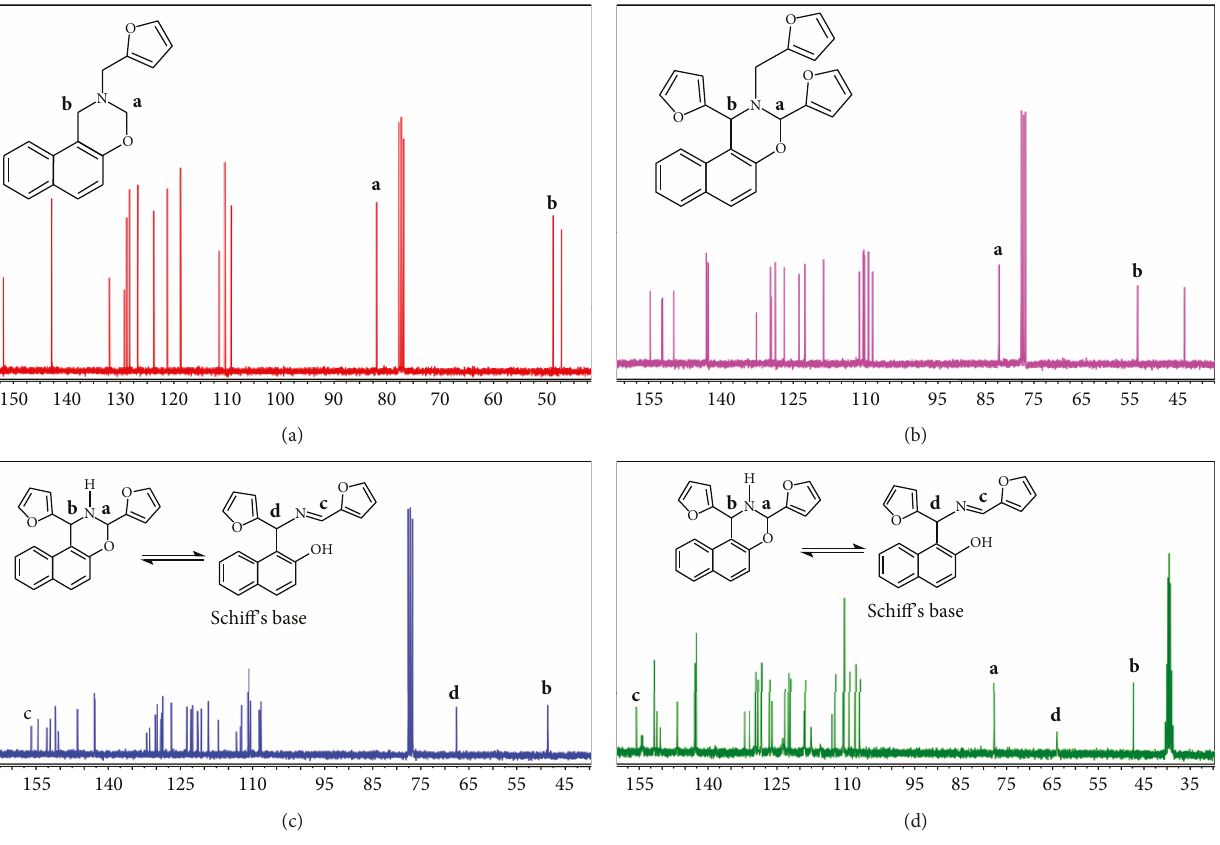
Figure 6: 13 C NMR of naphthoxazines containing furan groups. (a) Naft-Fu-H, (b) Naft-Fu-Fu, (c) Naft-H-Fu, and (d) Naft-H-Fu (in DMSO-d ). 6